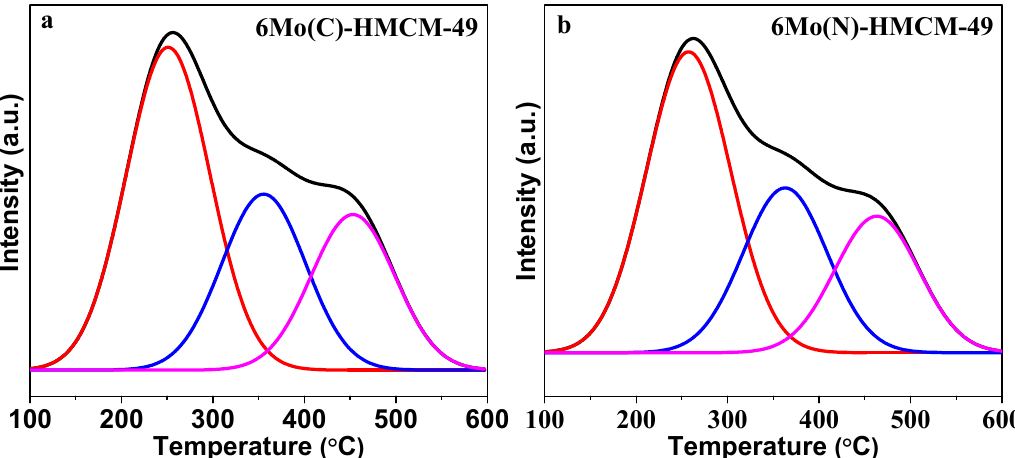
Figure 11. NH 3 -TPD profiles of the 6Mo(C)-HMCM-49 and 6Mo(N)-HMCM-49 catalysts after fitting curves.( a ) 6Mo(C)-HMCM-49,( b ) 6Mo(N)-HMCM-49